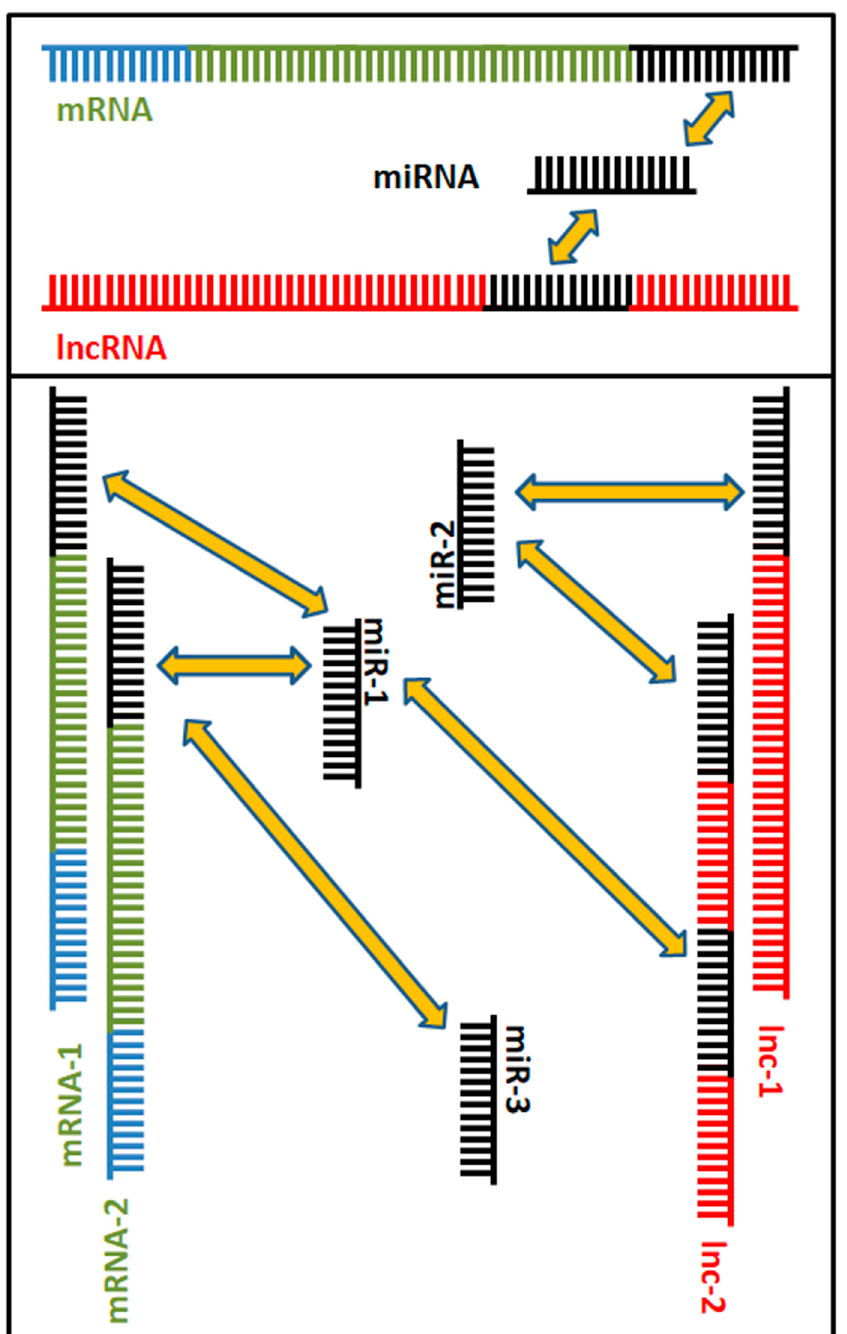
Figure 2. Competing endogenous RNA network. Top panel: In the easiest (and less common) situation, a basic ceRNET is composed of three actors: the mRNA, lncRNA, and miR (or miRNA). The interactions among them are sketched with the orange arrows. The long RNA molecules compete for the binding of the miR, and the relative concentration of these two decides the fate of target gene expression. If the concentration of the lncRNA is higher, all miR molecules are sequestered (sponged) and the mRNA can be translated into a protein; instead, if the lncRNA concentration is low, miR molecules can bind the target mRNA (usually at their 3 ′ -UTR end), promoting either its degradation or translation block. The binding occurs thanks to sequence homology (black sequences). Additional color codes: blue is the mRNA 5 ′ -UTR; green is the mRNA coding sequence; black is the mRNA 3 ′ -UTR, the miR, and the region of homology on the lncRNA; red is the part of the lncRNA that does not take part in the competition. For the sake of simplicity, the length of the described sequences is not in scale. Bottom panel: in most cases, the competition is